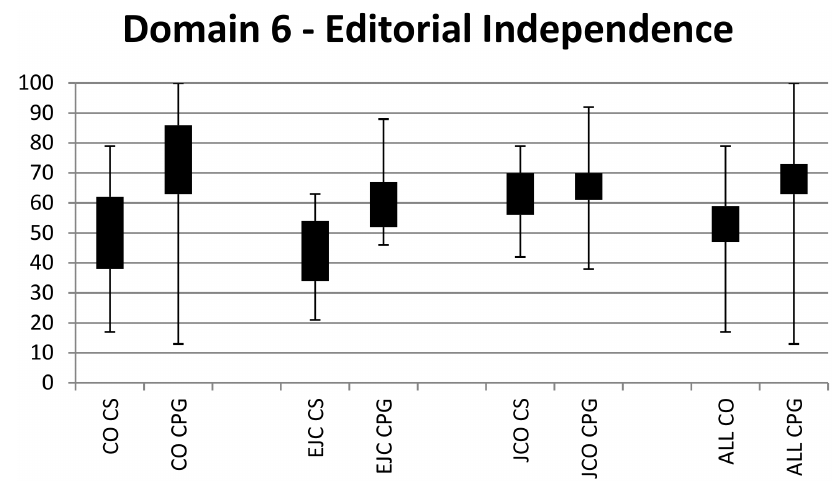
Figure 2. Range and 95% confidence intervals for Editorial independence scores. CO=Current Oncology. EJC=European Journal of Cancer. CS=Consensus statements. JCO=Journal of Clinical Oncology. CPG=Clinical practice guidelines.